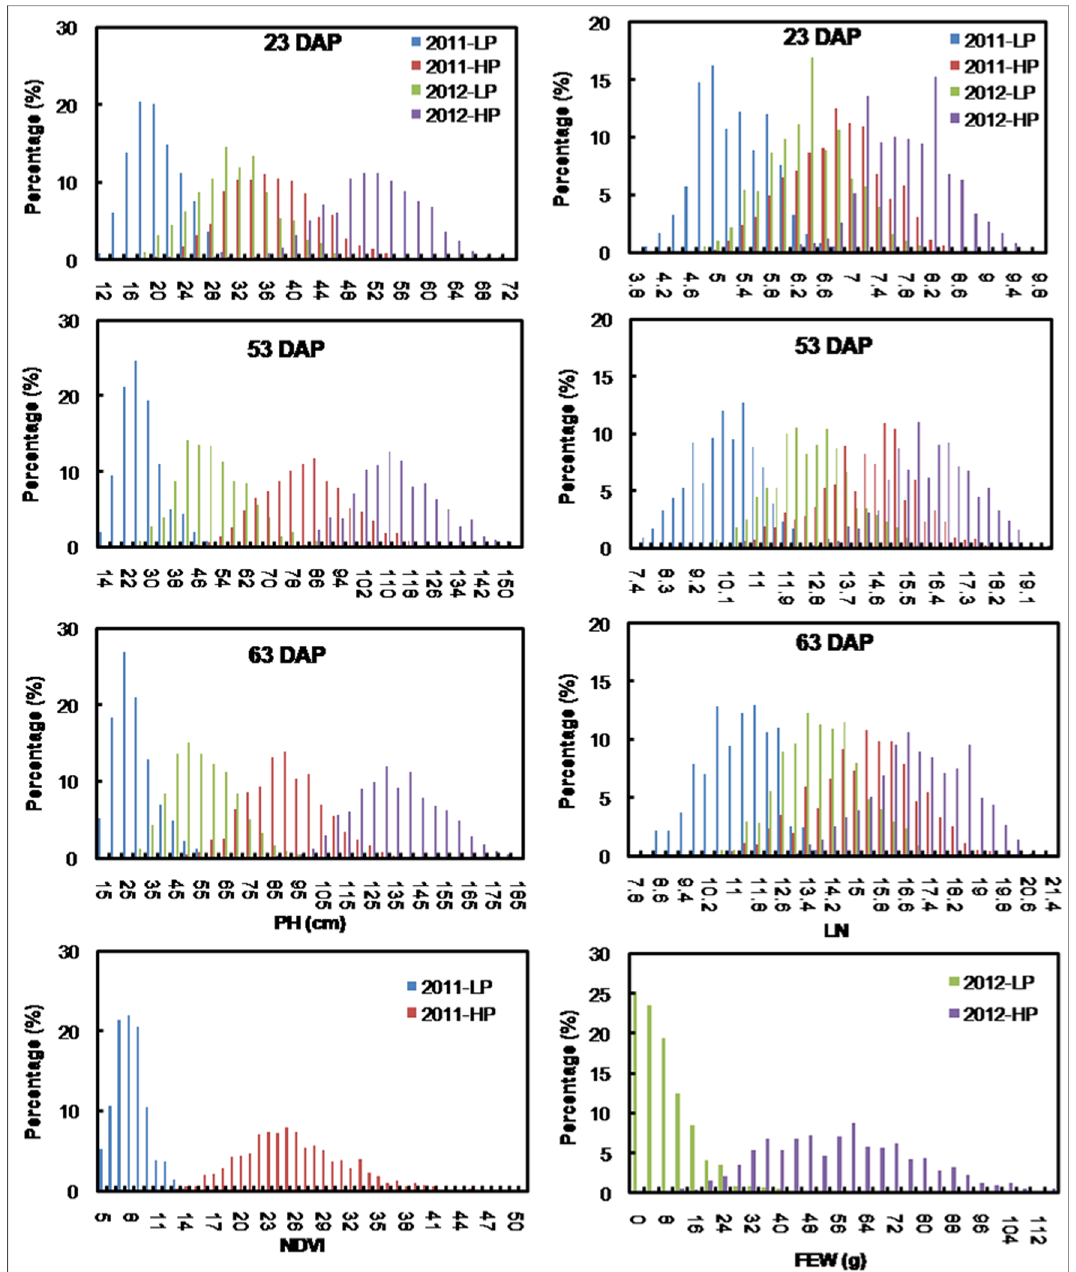
Fig 1. Distribution of all traits measured for 826 maize accessions. PH: plant height; LN: leaf number; NDVI: normalized difference vegetation index; FEW: fresh ear weight; DAP: days after planting; LP: low-P; NP: normal-P; Percentage: the number of accessions in each interval divided by the total number of